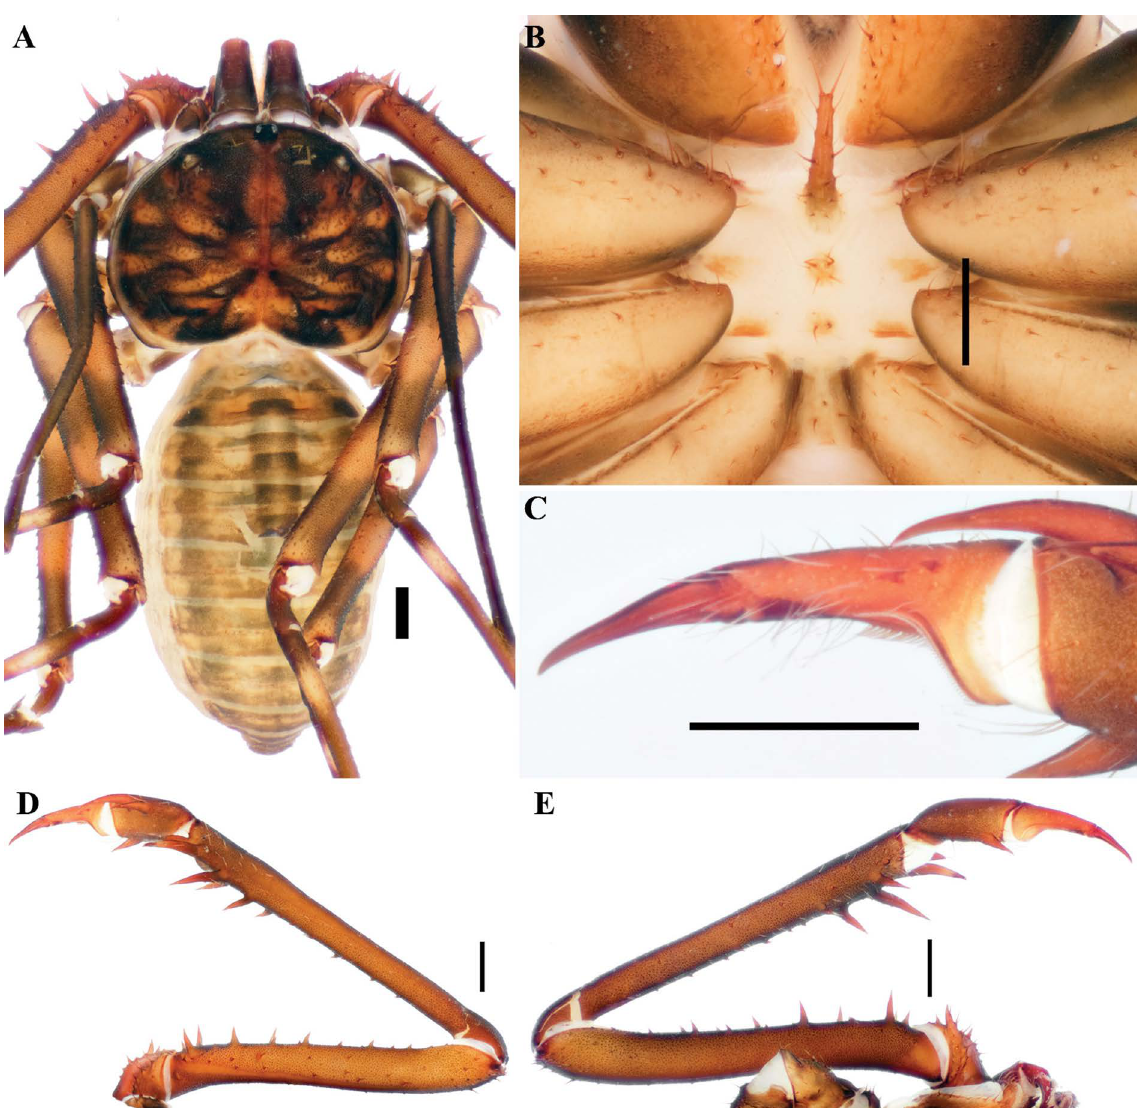
Fig. 125. Sarax sarawakensis (Thorell, 1888) (AMCC [LP 11594]), general morphology, ♂. A . Habitus, dorsal view. B . Sternum, ventral view. C . Pedipalp tarsus, frontal view. D . Pedipalp, dorsal view. E . Pedipalp, ventral view. Scale bars: 1